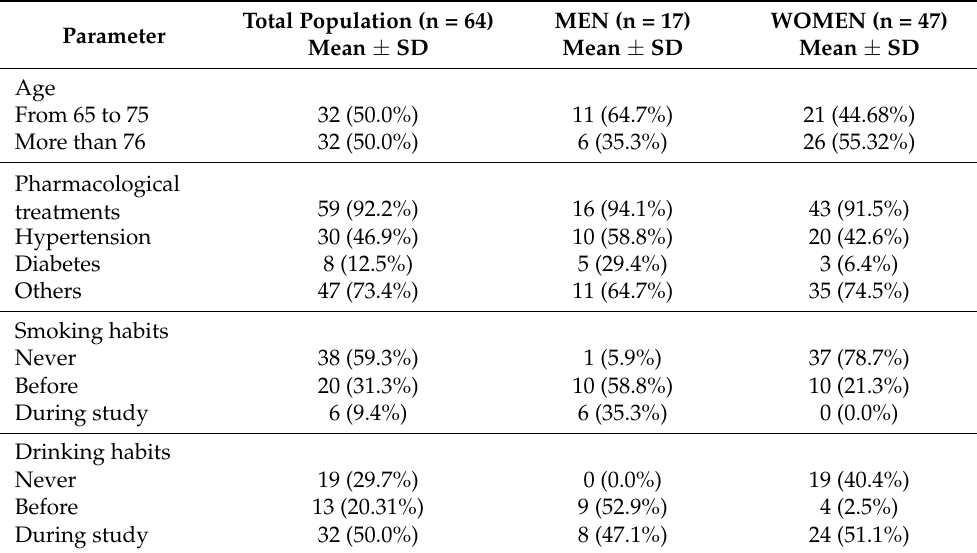
Table 1. Age, social and clinical characteristics of the participants in the study.